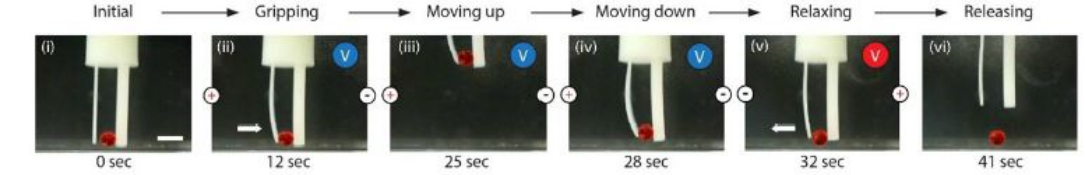
Figure 20. Actuation scheme of AA/PEG hydrogel under electrical stimulation [81]. Reprinted with permission from the American Chemical Society.